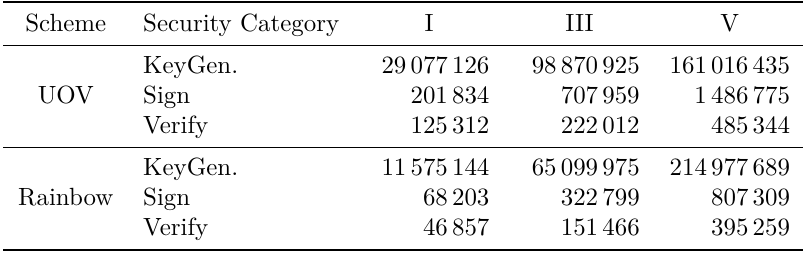
Table 2: UOV/Rainbow implementation results using AVX2 at three security categories in CPU